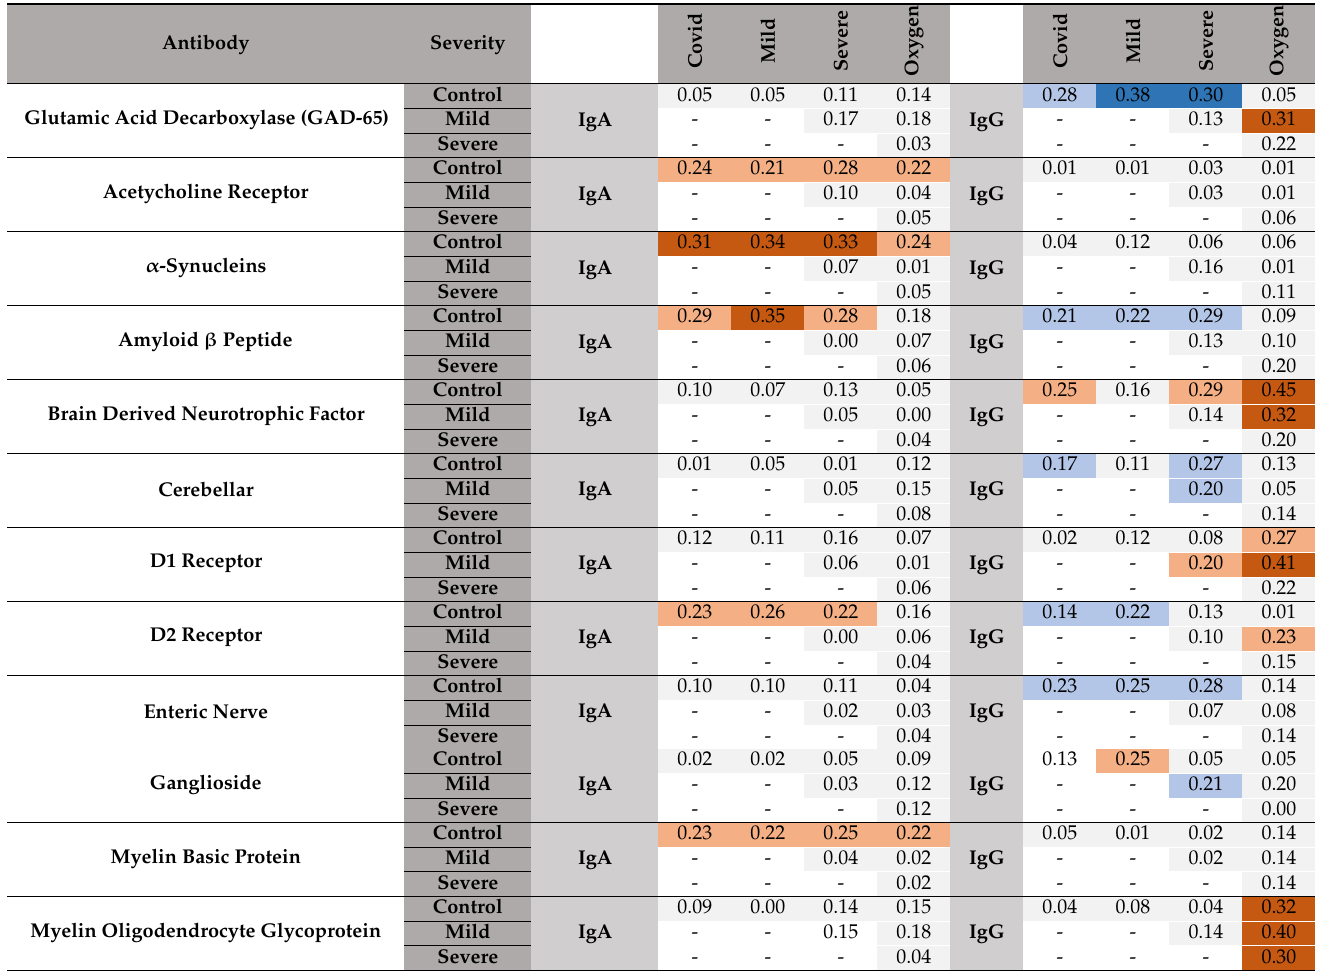
Table 1. Dysregulated levels of autoantibodies, whether elevated or lower, were observed throughout with severity of COVID-19 illness. The table above presents the effect size between the two groups. The color of the cells depicts the comparisons of the means of the latitudinal group relative to the longitudinal group. Antibodies against glial fibrillary acidic protein and glutamate receptors were omitted from this table because their levels were not observed to be dysregulated in COVID-19